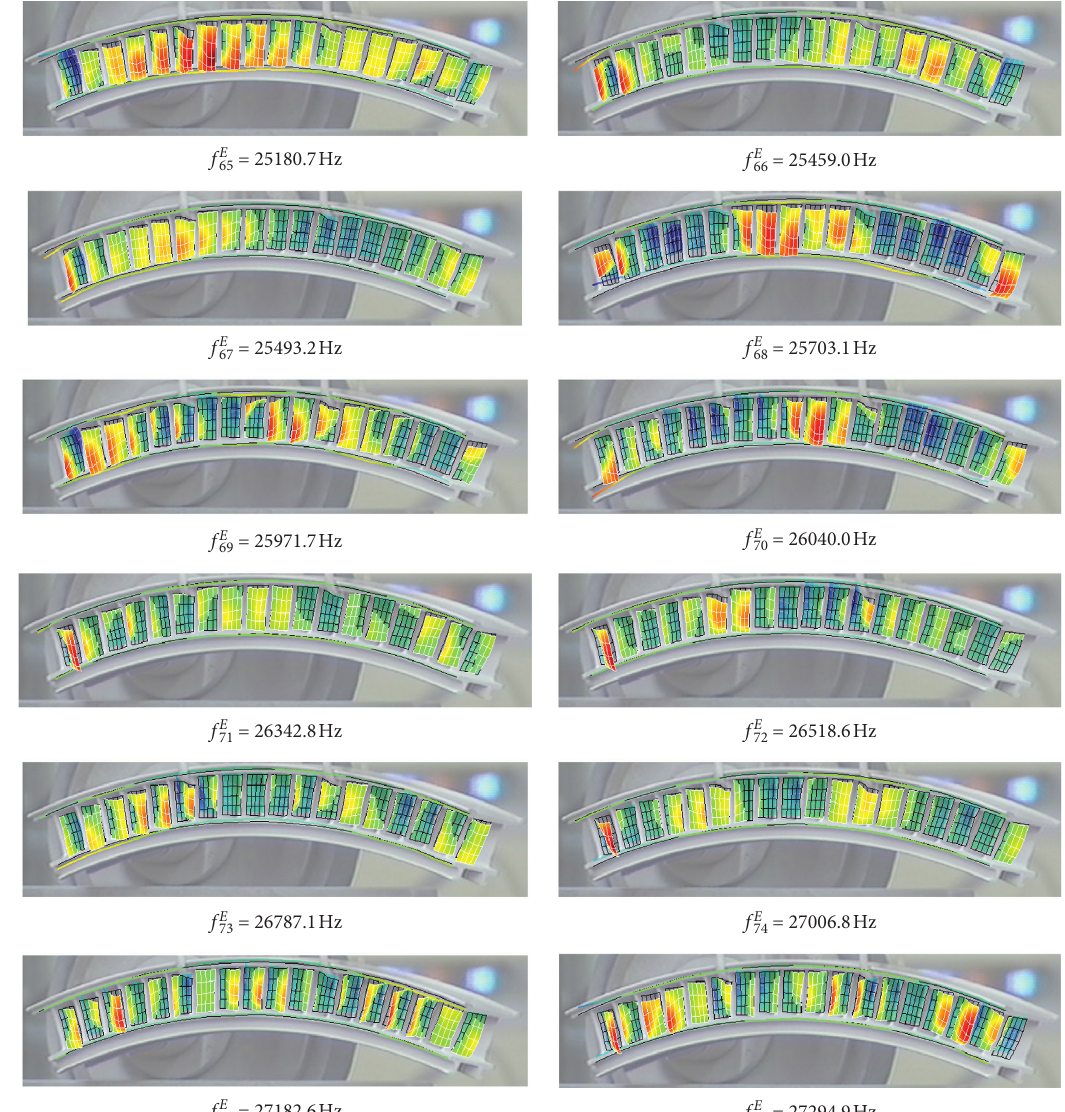
Figure 9: Natural frequencies and mode shapes for modes from 65 th to 76 th